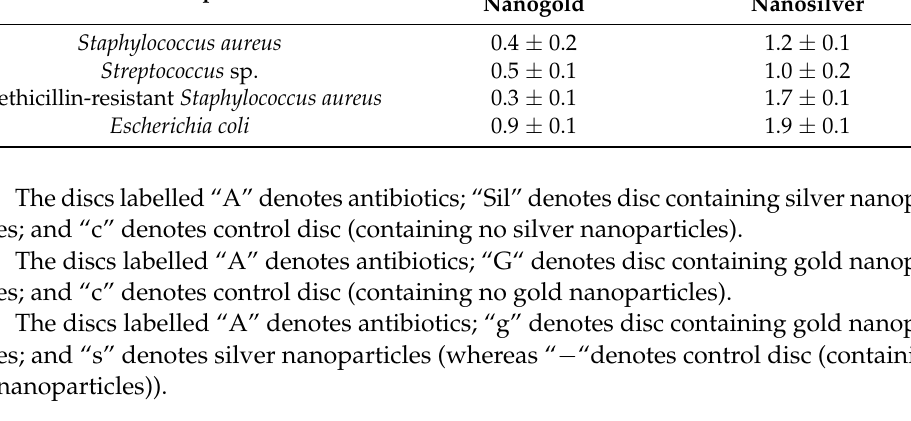
Table 1. Antibacterial activity of silver and gold nanoparticles of Chlorella vulgaris . Bacterial